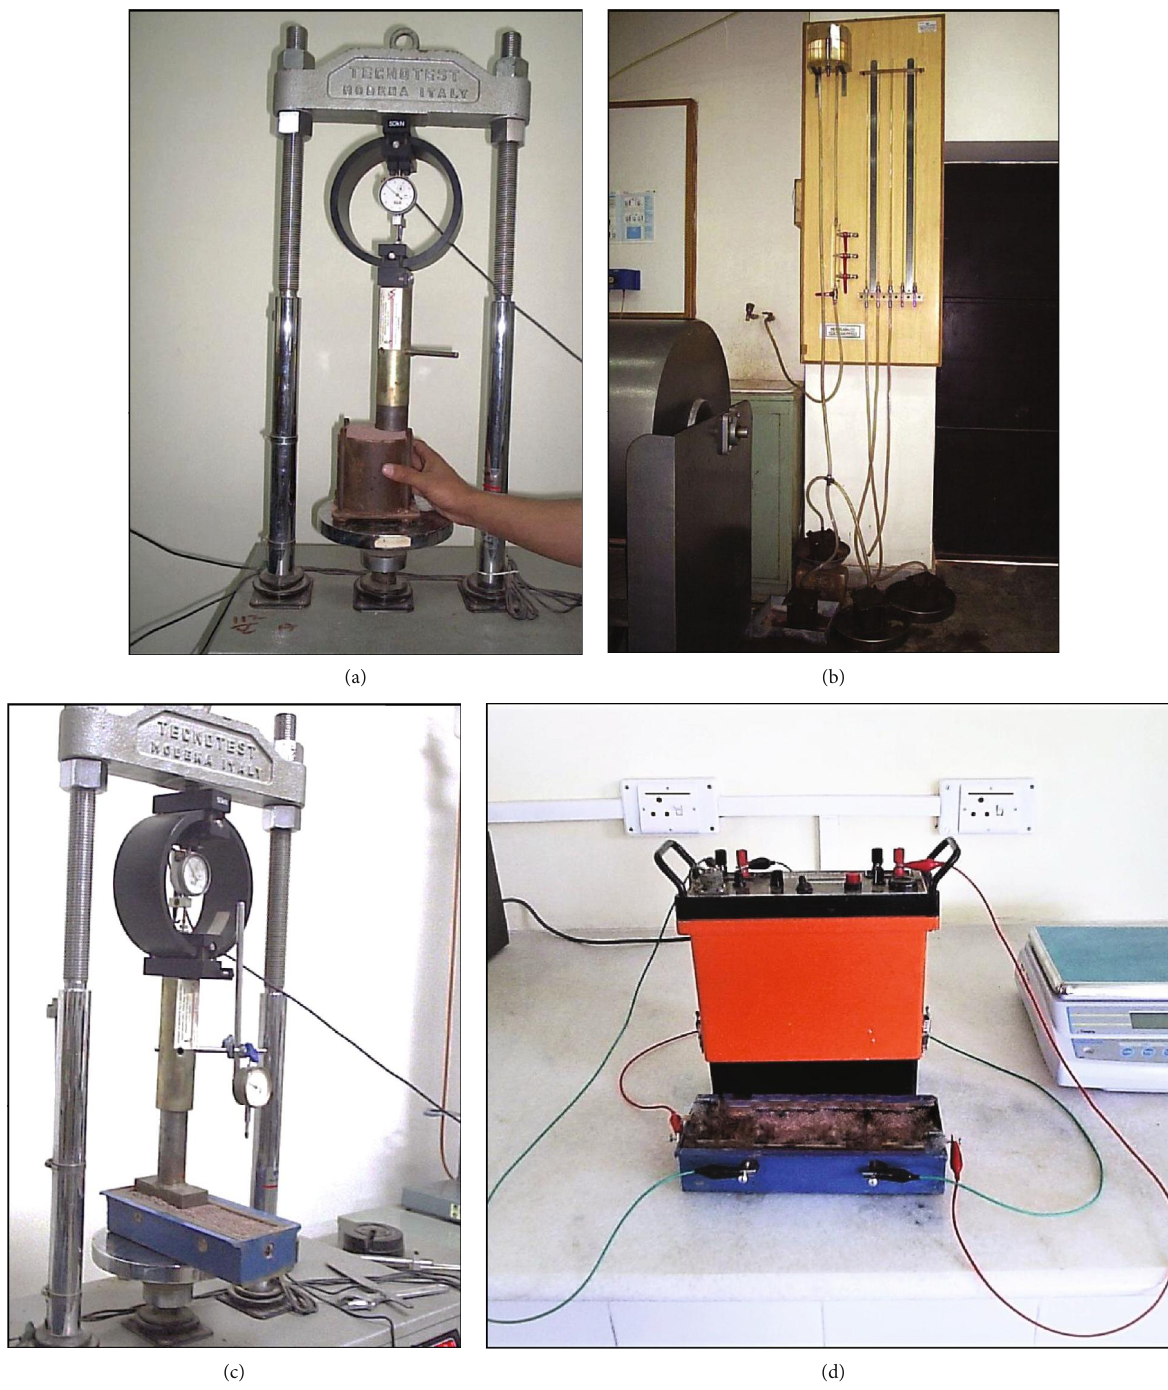
Figure 14: Selected laboratory tests on matrix material: (a) sample being compacted to the desired density in compaction-mold permeameter; (b) permeability test in progress on multiple samples; (c) sample being compacted to the desired density in the resistivity box; (d) resistivity box and sample connected to the resistivity meter with current and potential electrodes embedded in the